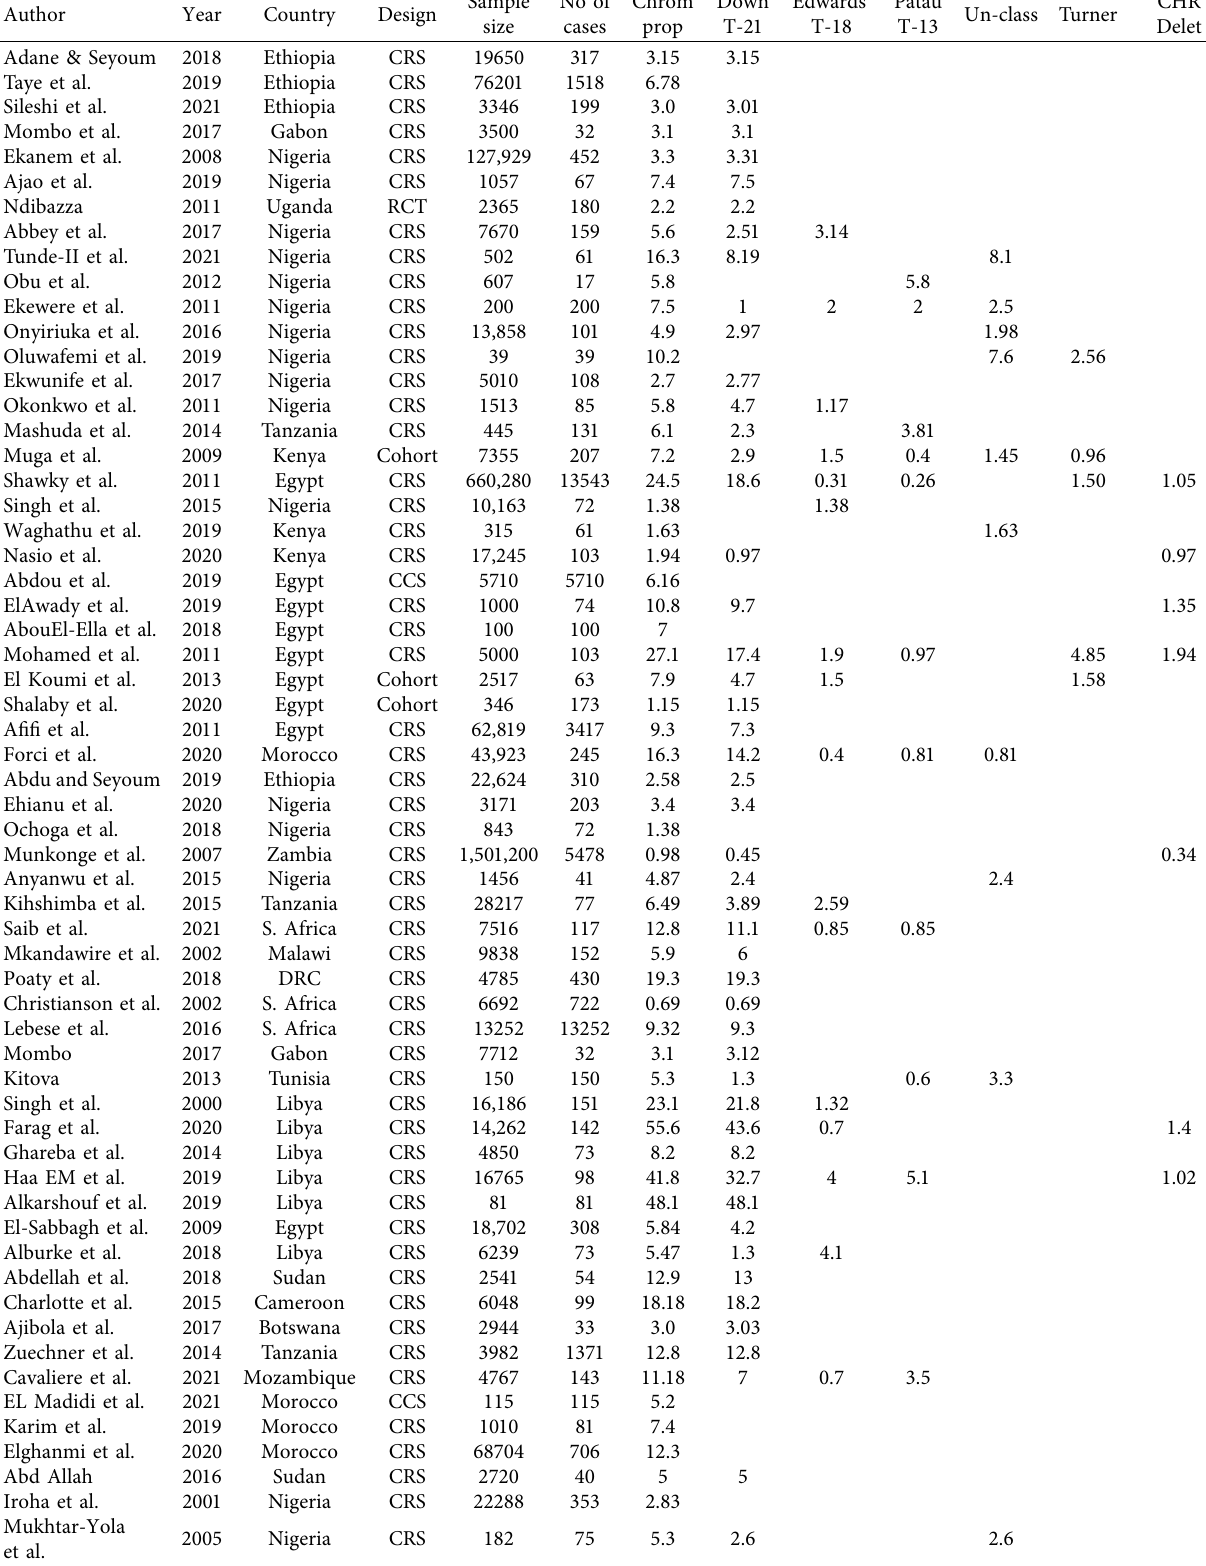
Table 1: Distribution of included studies on the proportion and patterns of chromosomal disorders among births with congenital anomalies in Africa, from January 2000 to October